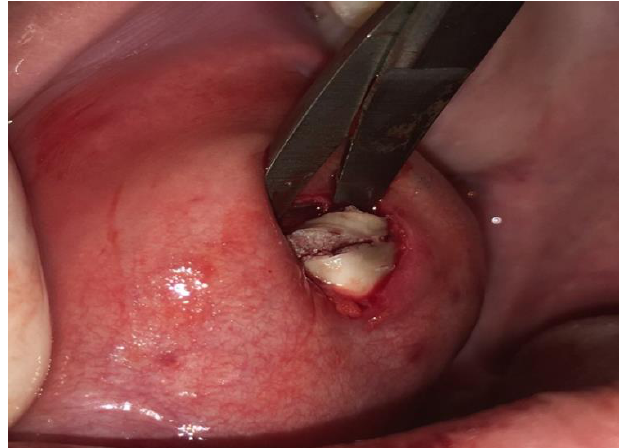
Figure 1. Sample of brownish colouration with an irregular surface and